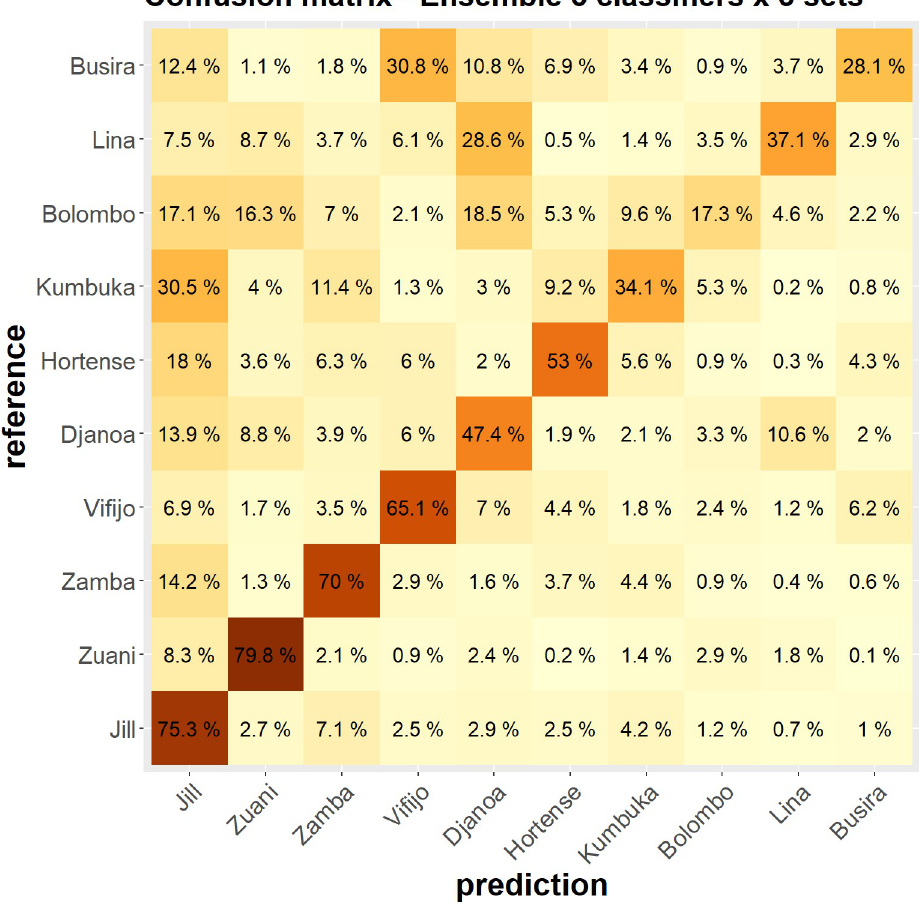
Fig 10. Average confusion matrix, for 100 iterations of the evaluation process, reporting the classification rates of the individual signatures in the best configuration (the ensemble classifier combining the 9 primary classifiers). Individuals are sorted from bottom to top by decreasing the number of calls (Jill: largest number; Busira: lowest number). Percentages are according to the reference and sum to 1 along rows. The value of a cell color is proportional to its percentage (the darker, the